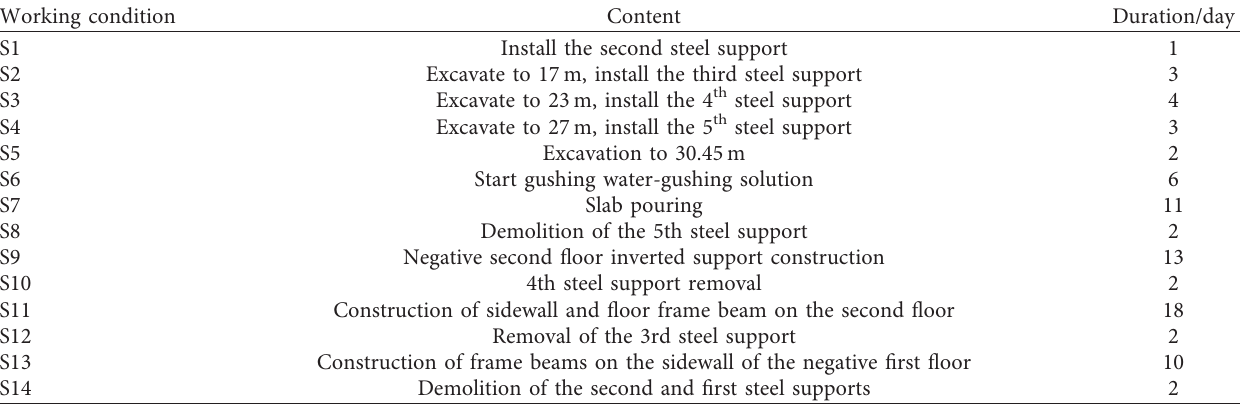
Table 3: Main analysis conditions of foundation pit.